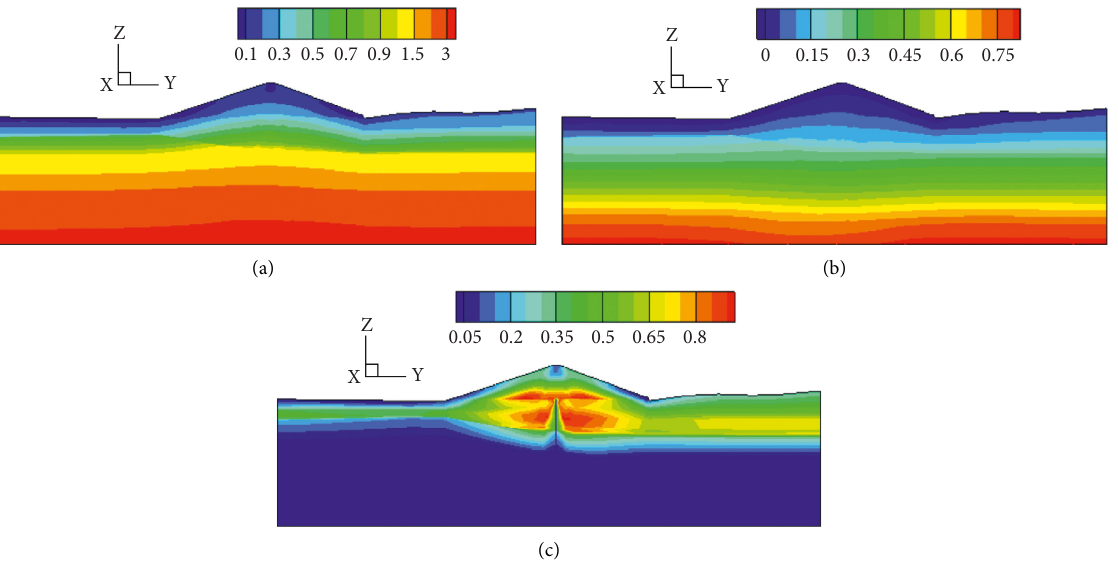
Figure 11: Cloud map of stress distribution of dam after the dissipation of the excess pore water pressure (MPa): (a) major principal stress; (b) minor principal stress; (c) total stress.